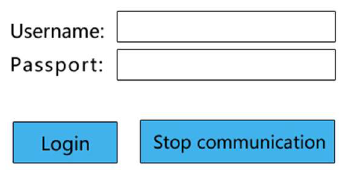
Figure 2. The login screen after compilation 5 Concludes Through Ajax technology and SSE, instant messaging of the server is realized, which reduces the burden of the server. SEE can be used to push data from the server side to the browser side in real time, which is easier to